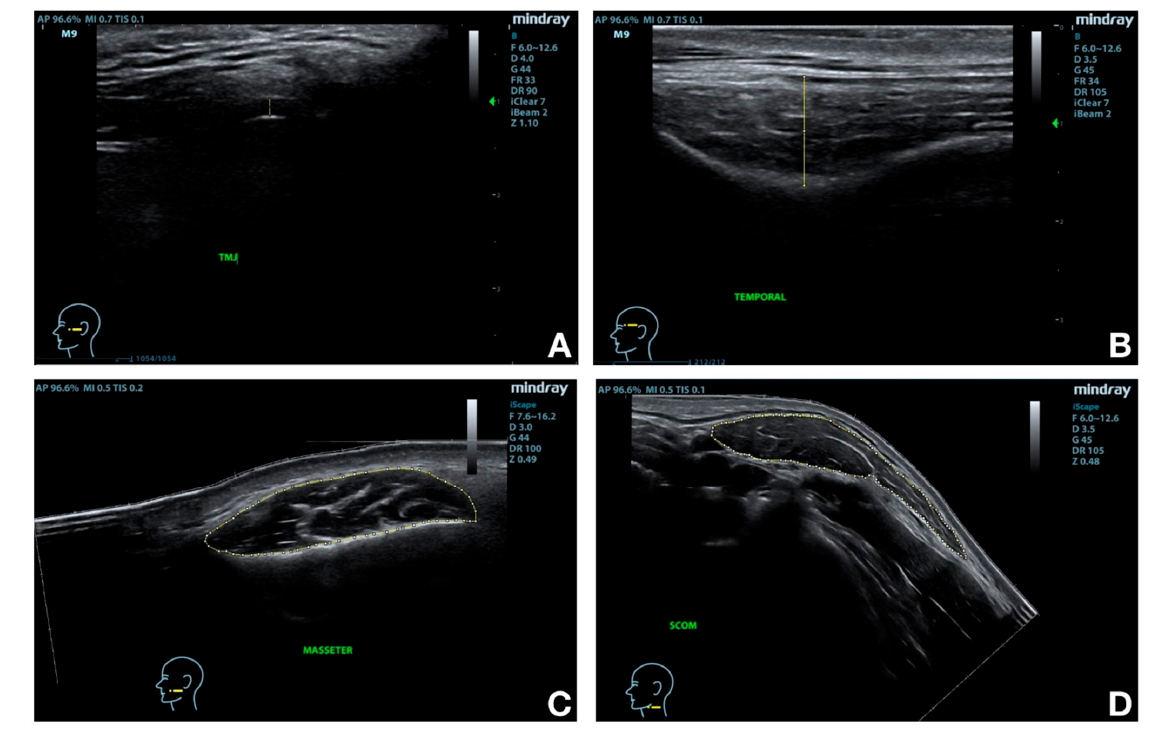
Figure 3. Target structures and main measurements. Temporomandibular joint (TMJ) articular disc thickness ( A ); Temporal muscle thickness ( B ); Masseter muscle cross-sectional area (CSA) ( C ); Sternocleidomastoid muscle CSA ( D ).